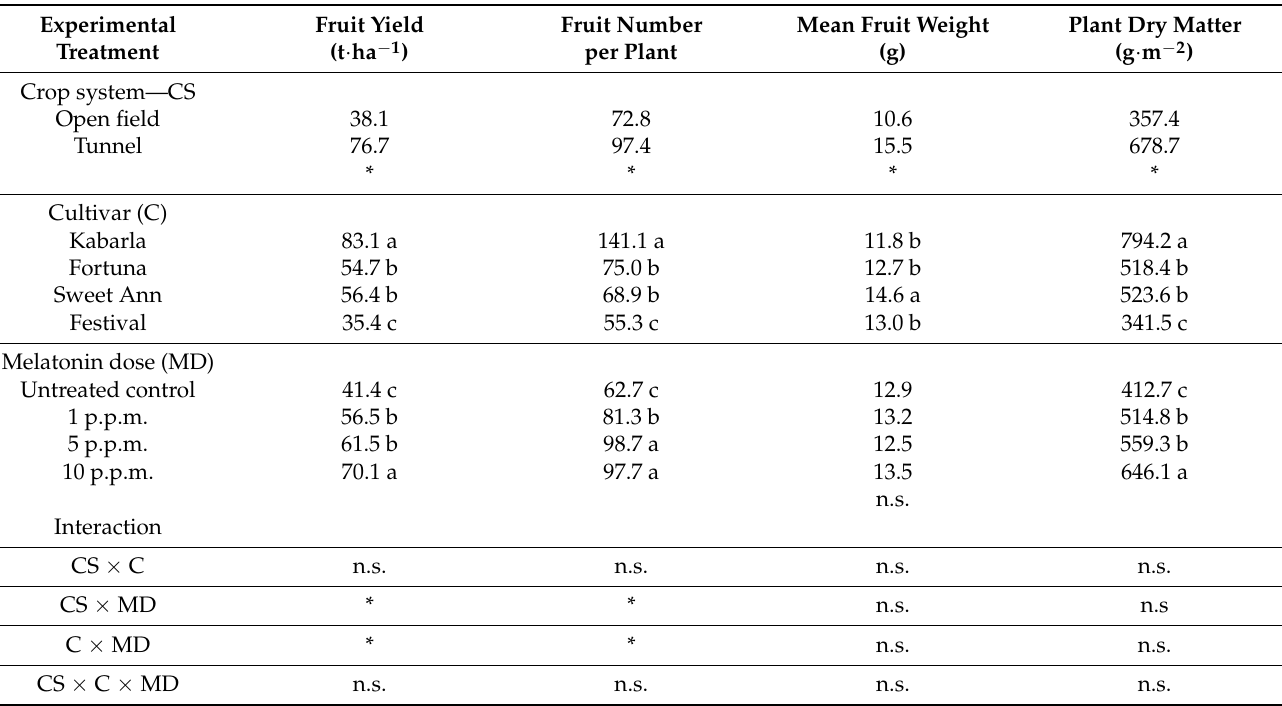
Table 1. Effects of crop system, cultivar and melatonin concentration on yield and growth parameters of strawberry grown in